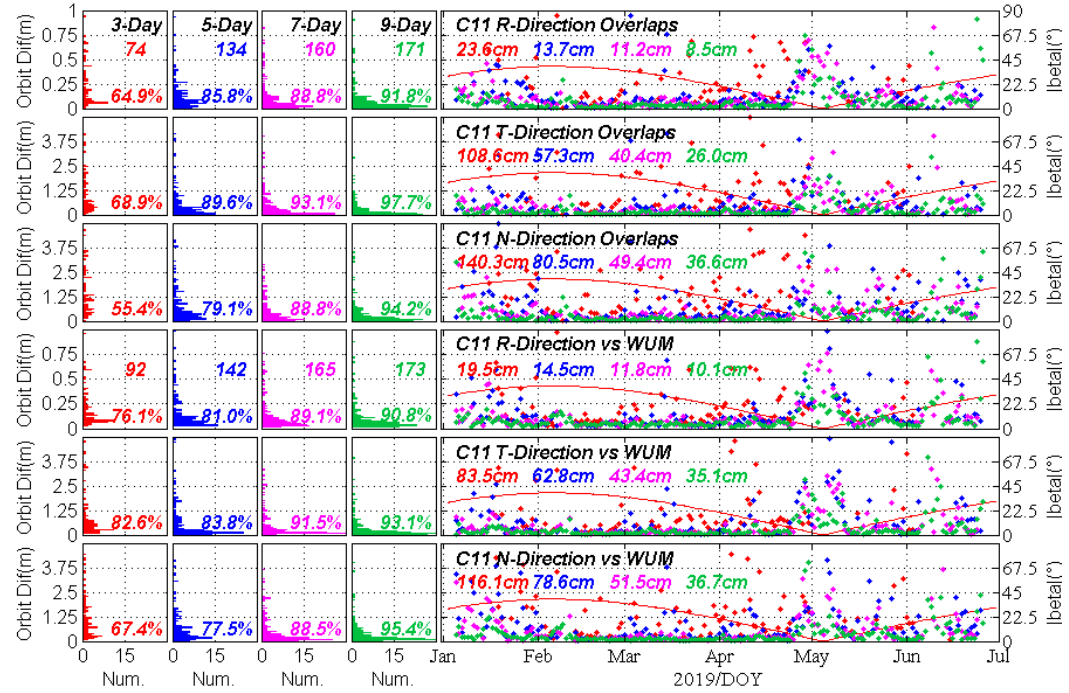
Figure 10. The results of SLR-only orbit determination for C11.